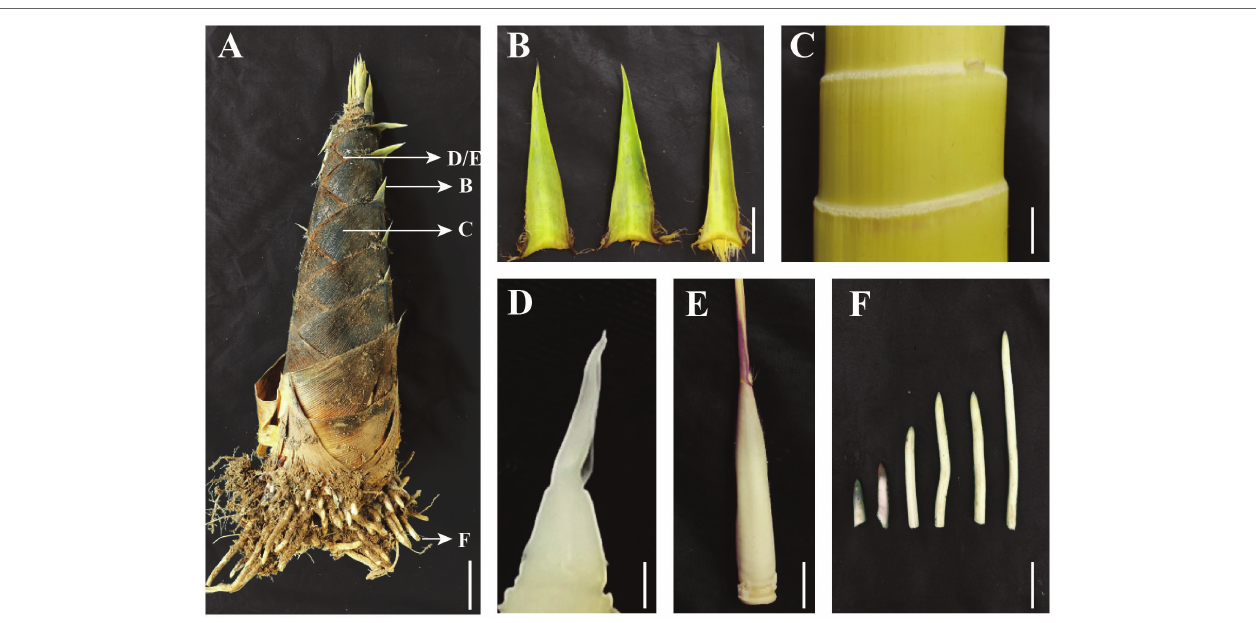
FIGURE 1 | Structure of moso bamboo shoots with corresponding sampling tissues (A) 50-cm-height moso bamboo shoot, (B) sheath blade (the upper component of culm sheaths, the base is connected to the tip of sheath and is the metamorphic leaf of bamboo shoot), (C) bamboo shoot internode 1/5 from the tip, (D) young sheath wrapped shoot tip, (E) intact young sheath, (F) root tip (the tip of the bamboo root growing out of the base of the bamboo shoot). (A) Bar = 5 cm, (B–F) Bar = 1